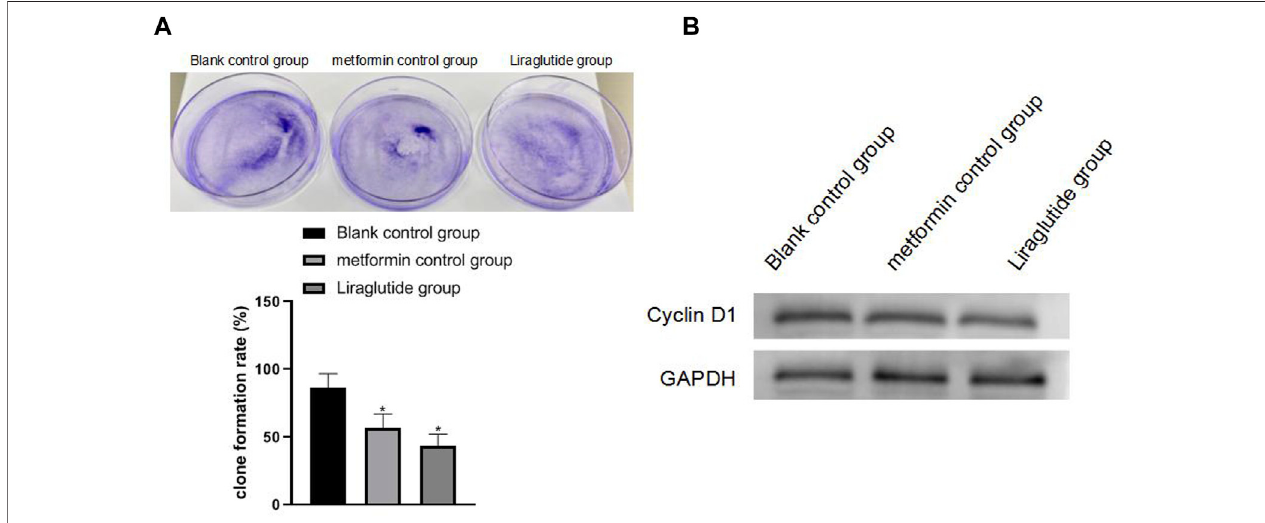
FIGURE 2 | Effects of GLP-1 receptor agonists on the proliferation and cycle of CRC cells. Note: (A) plate cloning experiment; (B) Western blotting experiment, compared with blank control group, * p < 0.05.